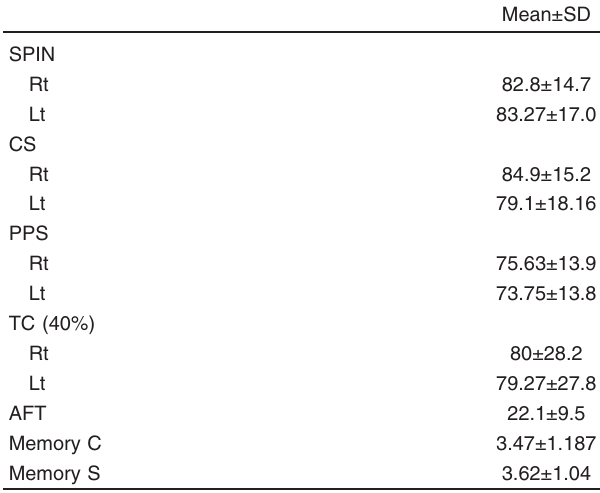
Table 1 Mean±SD of central auditory test battery scores (correct%)